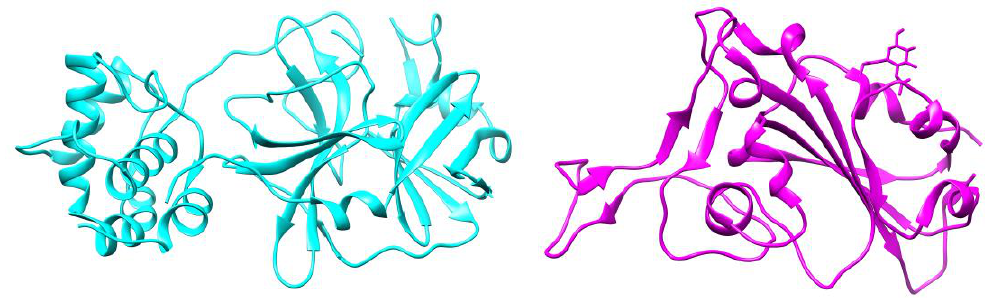
Figure 2. Three-dimensional crystal structure of the therapeutic targets of SARS-CoV-2 M pro main protease (PDB ID: 6LU7, cyan) and spike glycoprotein (PDB ID: 6M0J, magenta). Compounds scoring lower than − 5.00 kcal/mol are expected to be active. These compounds were then filtered by RMSD value [30], to evaluate experimental stability of the docked ligand conformers. RMSD values around 1.5 Å, are considered successful and stable while those beyond 2 Å indicate instability of ligand conformation and docking parameters [36]. For SARS-CoV-2 protein M pro , the binding energy observed for these compounds ranged from − 7.950 to − 0.339 kcal/mol while for spike glycoprotein, binding energy ranged from − 8.088 to − 5.437 kcal/mol. The top three scoring compounds for SARS-CoV-2 protein M pro were compound 132 (2 (cid:48) -oxo-2 (cid:48) -O-(3,4-dihydroxy- E -cinnamoyl)- (2 (cid:48) R ) aloesinol-7-methyl ether), compound 134 (2 (cid:48) -oxo-2 (cid:48) -O-(4-hydroxy-3-methoxy-( E )- cinnamoyl)-(2 (cid:48) R )-aloesinol-7-methyl ether) and compound 159 (rutin), (Table 1 docking with the active site of SARS-CoV-2 protein M pro . Molecular 2D and 3D interactions com- plexes of compounds 132 , 134 and 159 with SARS-CoV-2 protein M pro are shown in Figure 6. On the other hand, the top three scoring compounds for SARS-CoV-2 spike gly- coprotein were compounds compound 115 (2”-O-(4-methoxycinnamoyl)-( S )-aloesinol), compound 120 (rabaichromone), and compound 131 (aloeribide), (Table 1 docking score, and Figure 5, lower